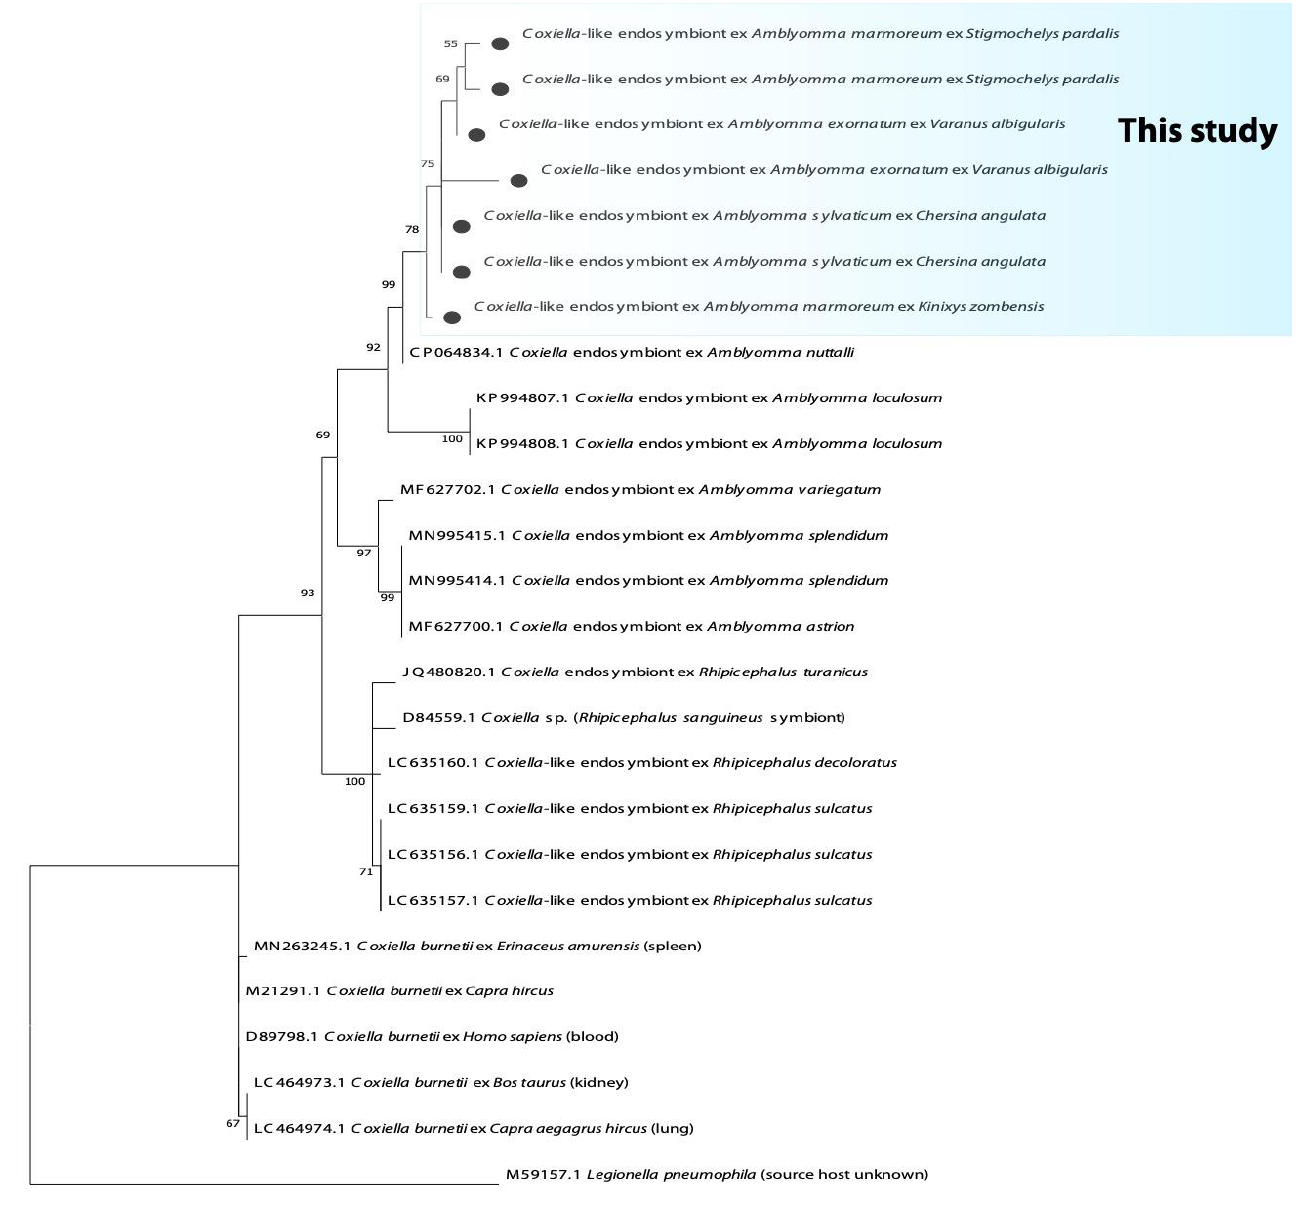
Figure 4. Phylogenetic tree based on the sequences of the Coxiella 16S rRNA gene. The tree was constructed using MEGA 11 based on the maximum likelihood, using the Kimura 2-parameter model. The sequences obtained in this study are indicated with bullets.